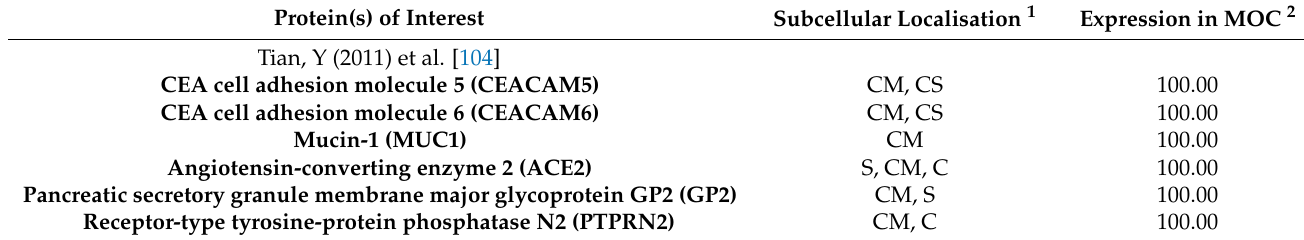
Table 2. Proteomic expression profiles of the selected proteins, with comparison to a control proteome. Protein(s) of Interest Subcellular Localisation